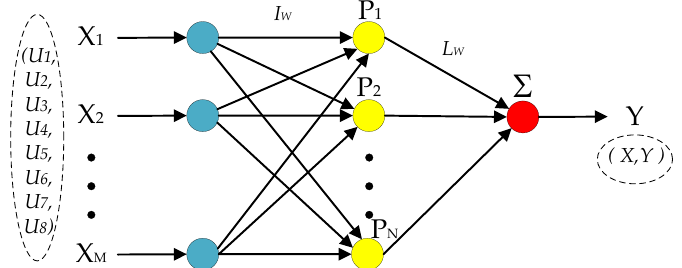
Figure 2. Structure diagram of RBF neural network.